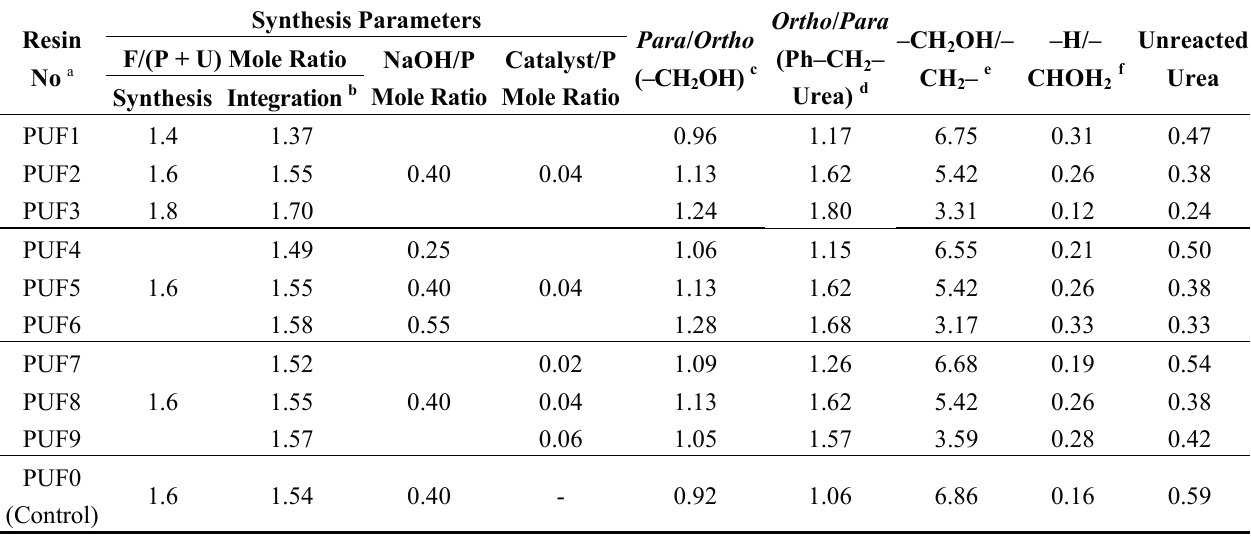
Table 3. Quantitative 13 C-NMR analysis results of PUF